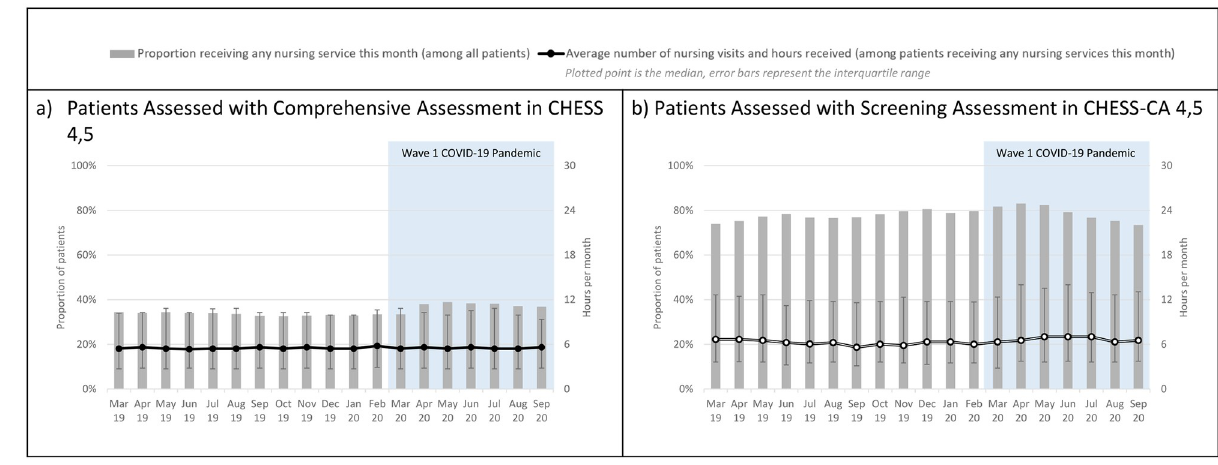
Fig 4. Receipt of nursing services (including shift nursing) among patients with high health instability.